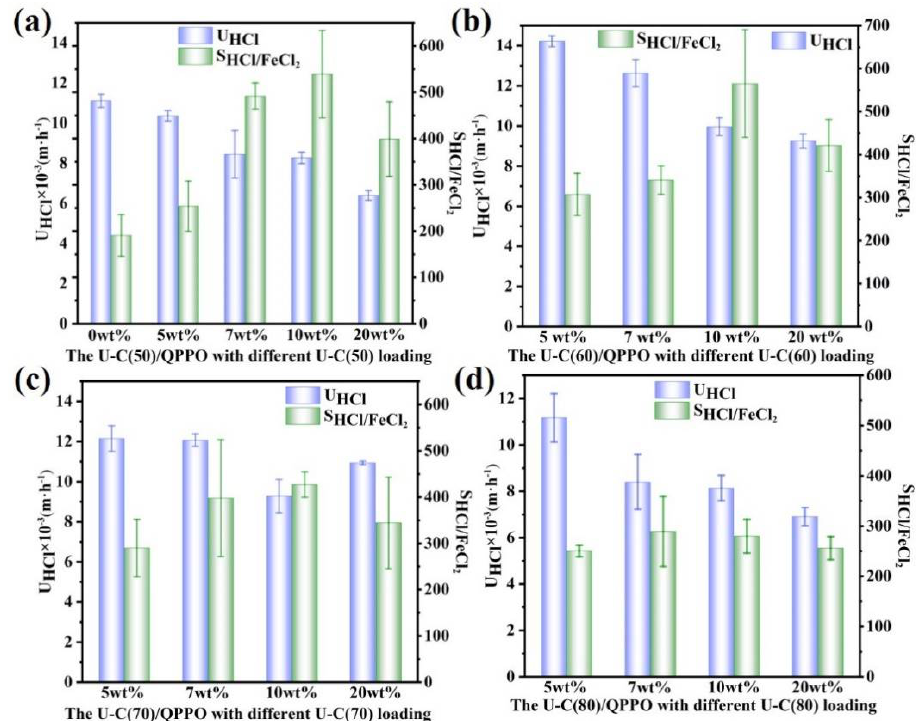
Figure 4. H + dialysis coefficient (U HCl ) and H + /Fe 2+ separation factor (S HCl/FeCl2 ) of UiO-66- (COOH) 2 /QPPO with four kinds of MOF with different carboxyl group contents under different MOF loadings. ( a ) U-C(50)/QPPO, ( b ) U-C(60)/QPPO, ( c ) U-C(70)/QPPO, and ( d ) U-C(80)/QPPO.